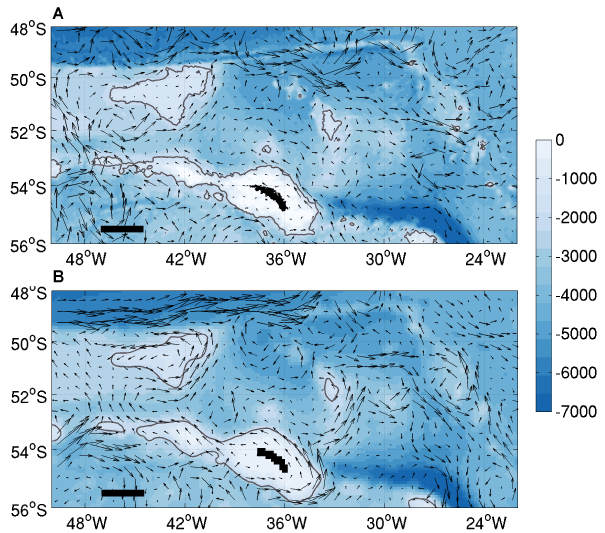
Fig. 4. Surface circulation (black arrows) in the South Georgia area, as obtained from (A) Aviso satellite altimetry for January–February 2008 and from (B) model results for January–February of the last modelling year. Background colours indicate bottom topography. For reference, the 2000m bathymetry is indicated with thin lines. In both panels, the horizontal bar in the bottom-left corner indicates 1ms − 1 , and corresponds to approximately 160km. Modelled sur- face circulation is interpolated onto the coarser grid resolution of satellite